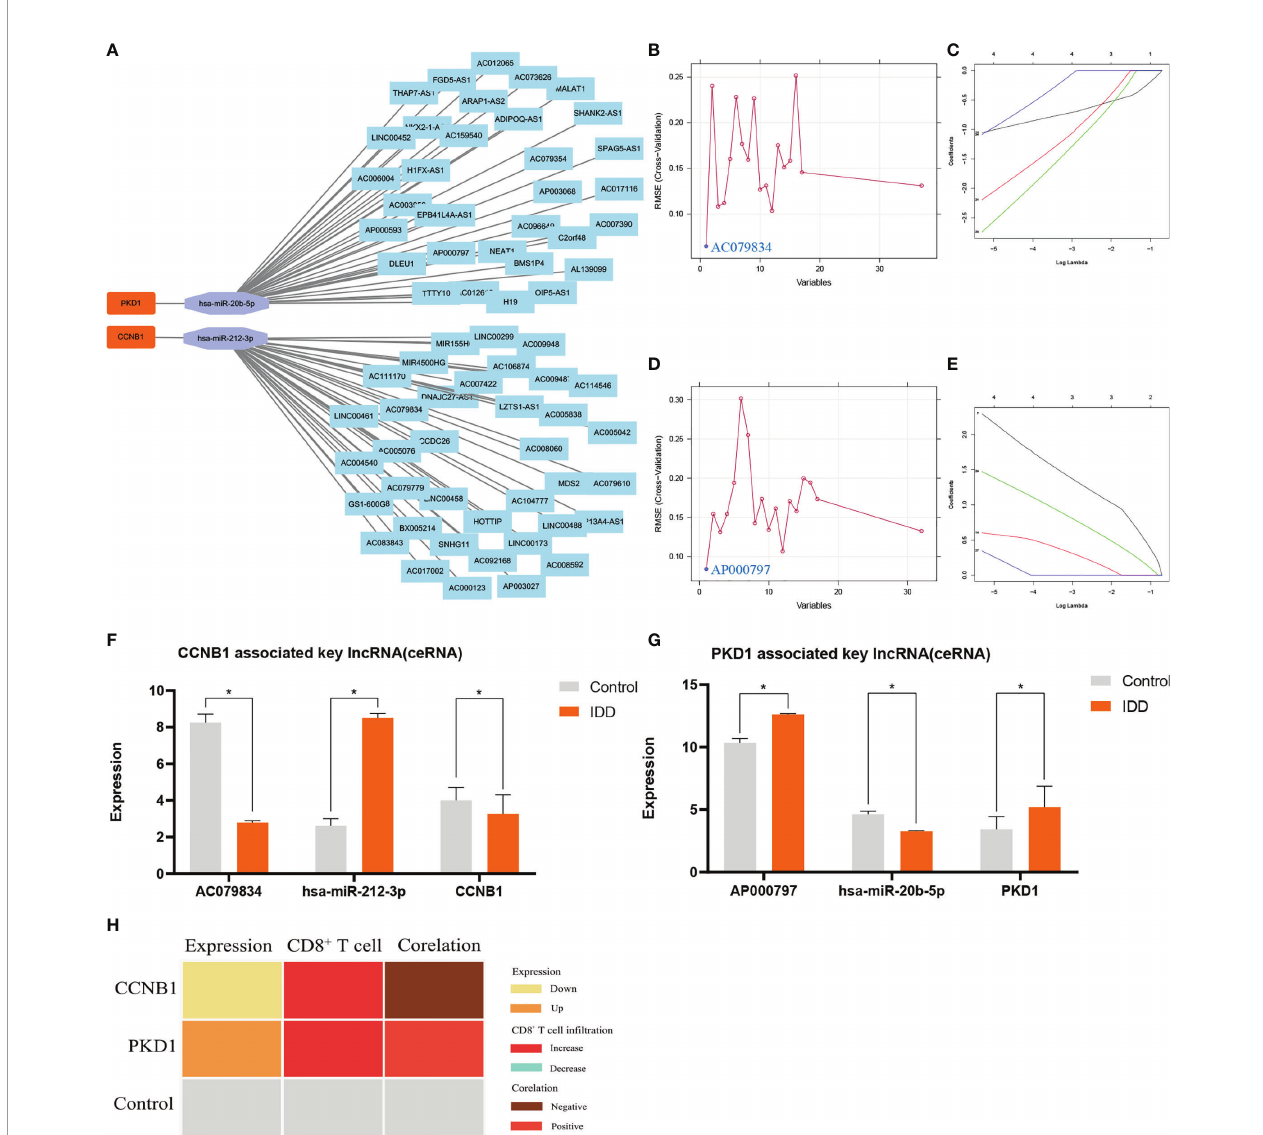
FIGURE 6 | |The 69lncRNAs – 2miRNAs – 2mRNAs ( CCNB1 / PKD1 pair) ceRNA co-expression network was constructed (A) and was used to screen the key ceRNAs (lncRNAs) by SVM (B, D) and Lasso (C, E) . Panels (B, C) , venn result for SVM (B) and LASSO (C) is AC079834 . LncRNA AC079834 was selected in SVM and LASSO, and was used for building axis ( CCNB1 – miR-212-3p – AC079834 ). Panels (D, E) , venn result for SVM (D) and LASSO (E) is AP000797 . LncRNA AP000797 was selected in SVM and LASSO, and was used for building axis ( PKD1 – miR-20b-5p – AP000797 ). Parameters and results in detail are shown in Supplementary Tables S9, S10 .The expression pro fi le for CCNB1 – miR-212-3p – AC079834 axis (F) and PKD1 – miR-20b-5p – AP000797 axis (G) . The low expression of CCNB1 is negatively correlated with increased CD8 + T cells in fi ltration; the high expression of PKD1 is positively correlated with increased CD8 + T cells in fi ltration (H) . * represents p <